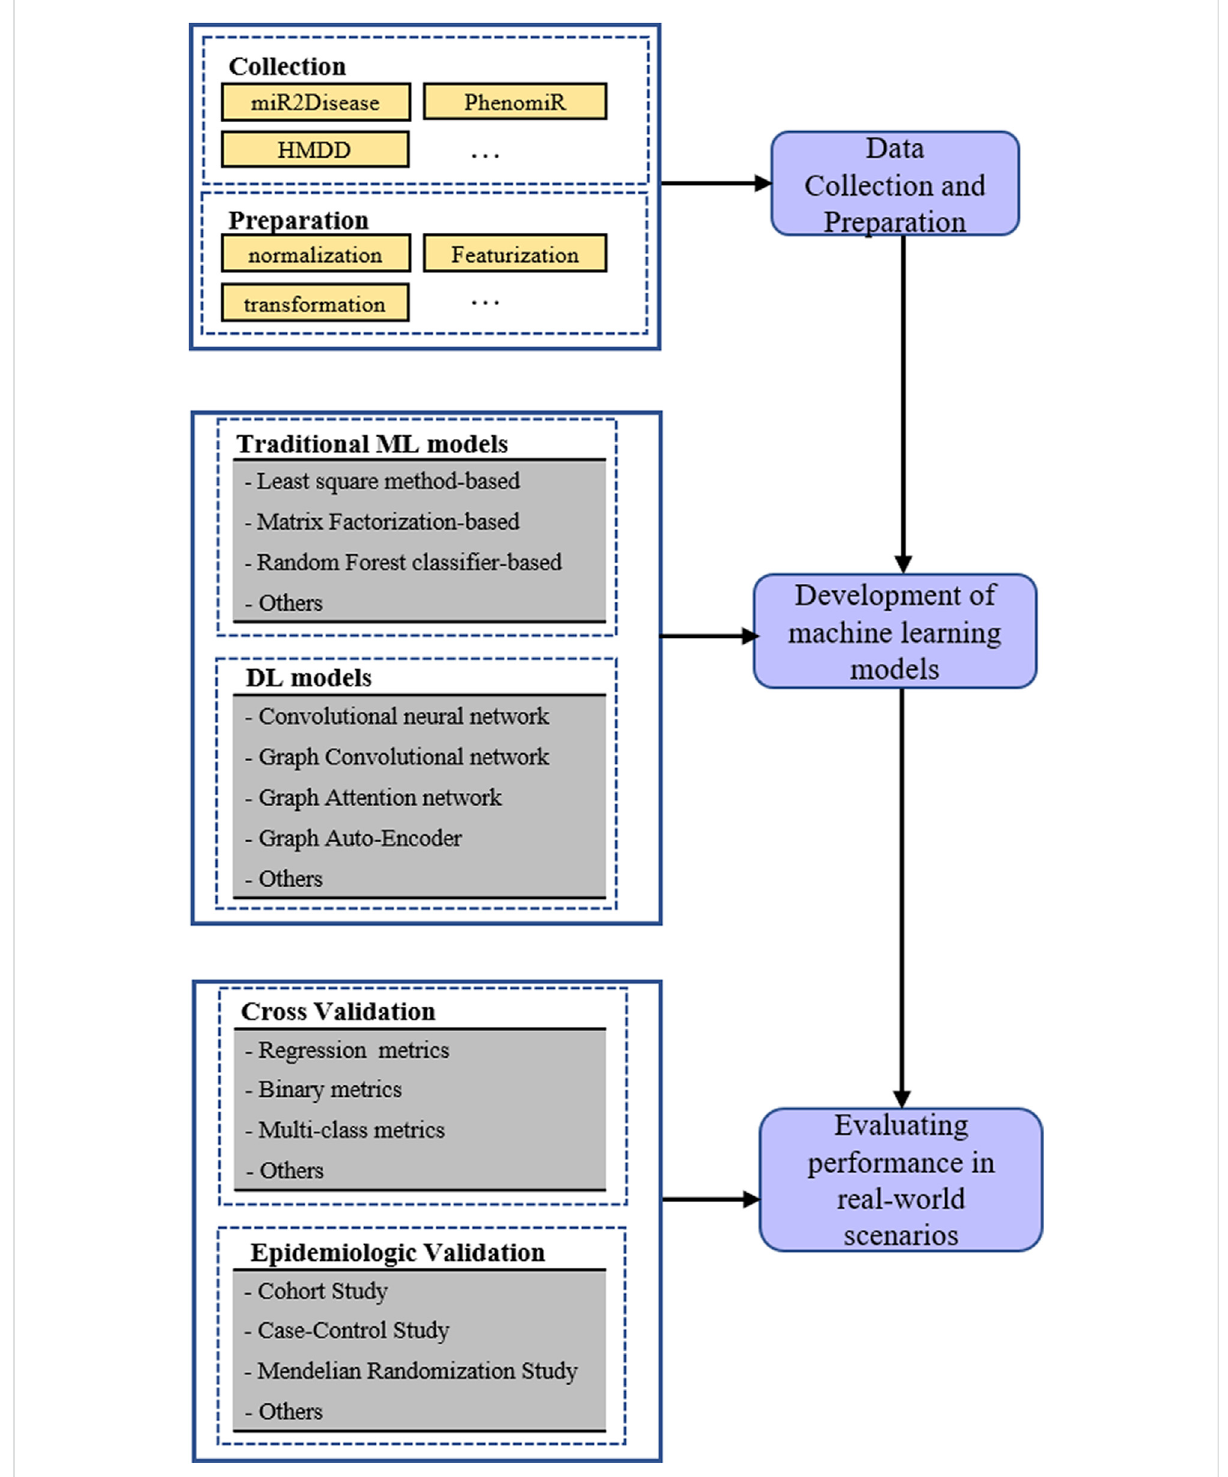
FIGURE 1 The processes of machine learning models for predicting miRNA-disease